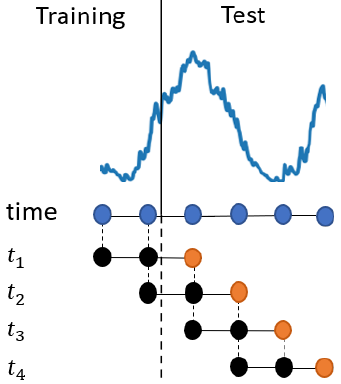
Figure 6. Example of individual LSTM